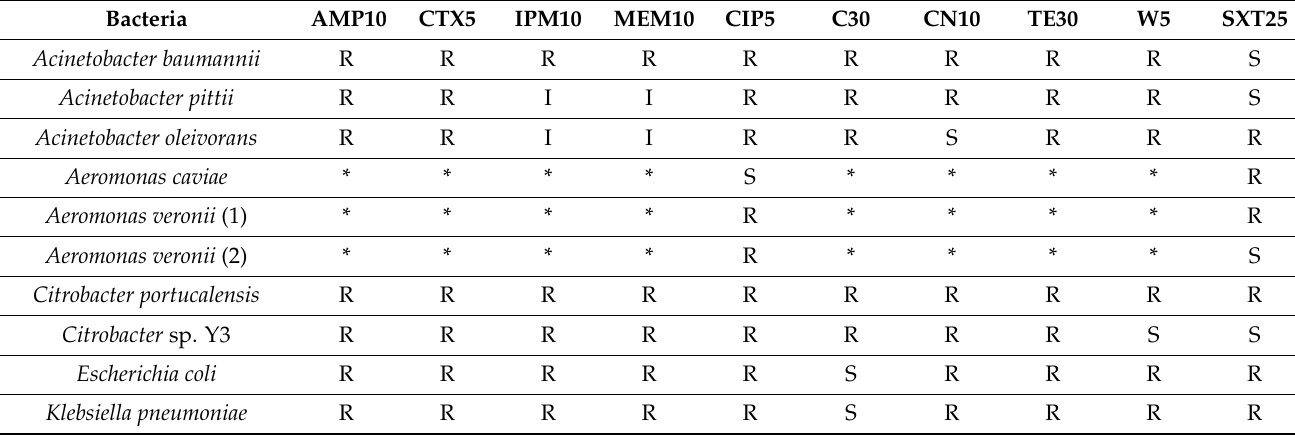
Table 1. AB resistance phenotype of the potentially pathogenic carbapenem resistant bacteria isolated from the discharged effluent